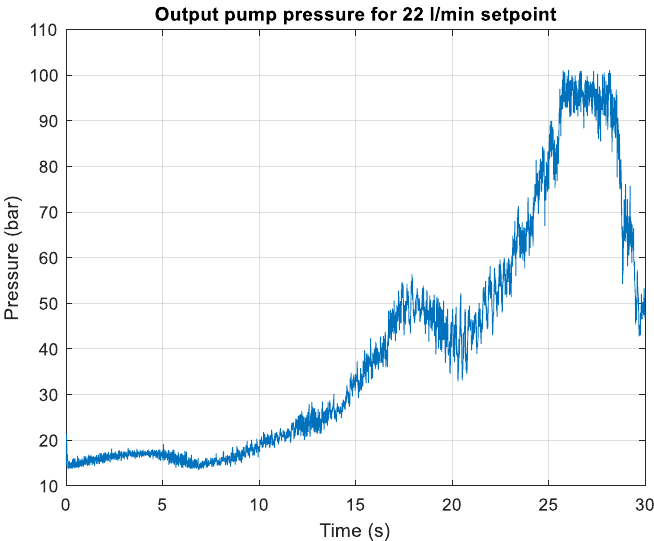
Figure 23. Output pump pressure for 22 L/min setpoints.